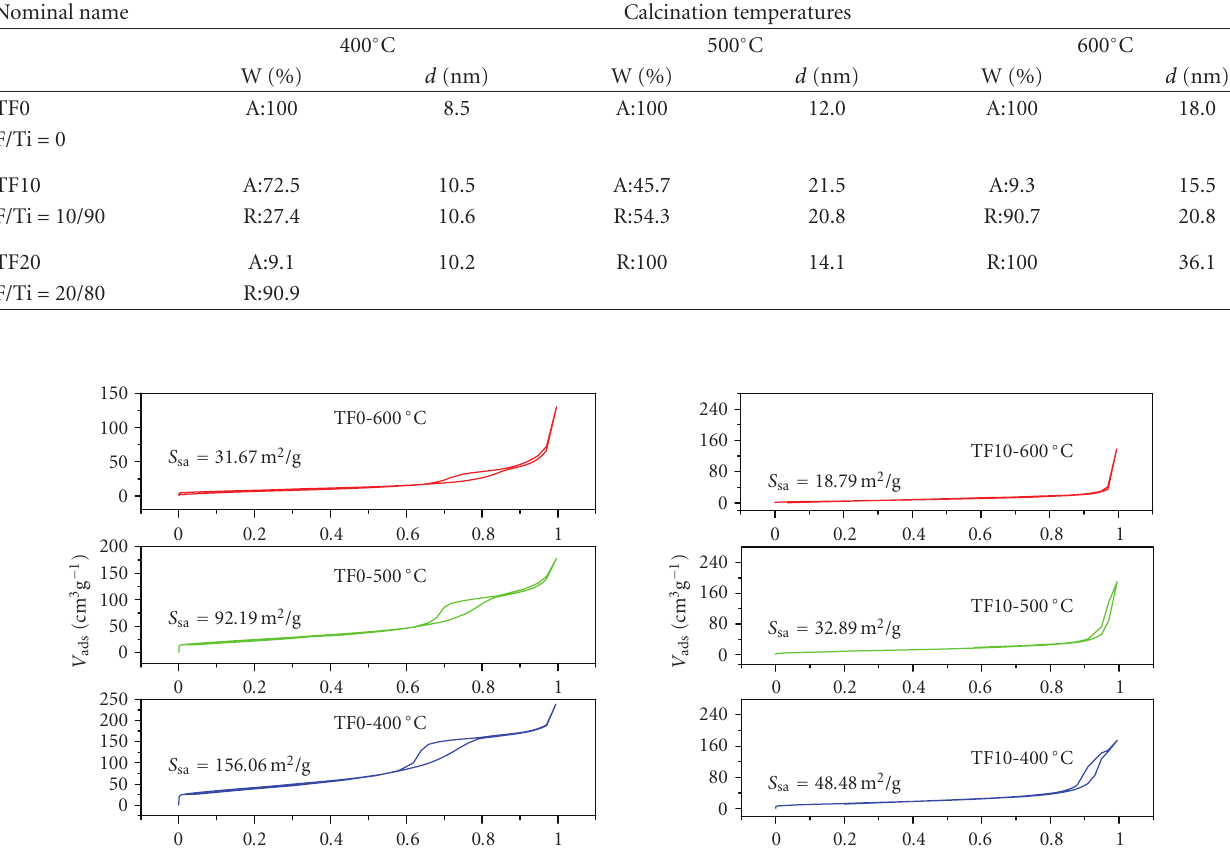
Table 1: Phase content W (%) and average diameter d (nm) of the crystallites in the TiO 2 powders calcinated at di ff erent temperatures (A: Anatase, R: Rutile).